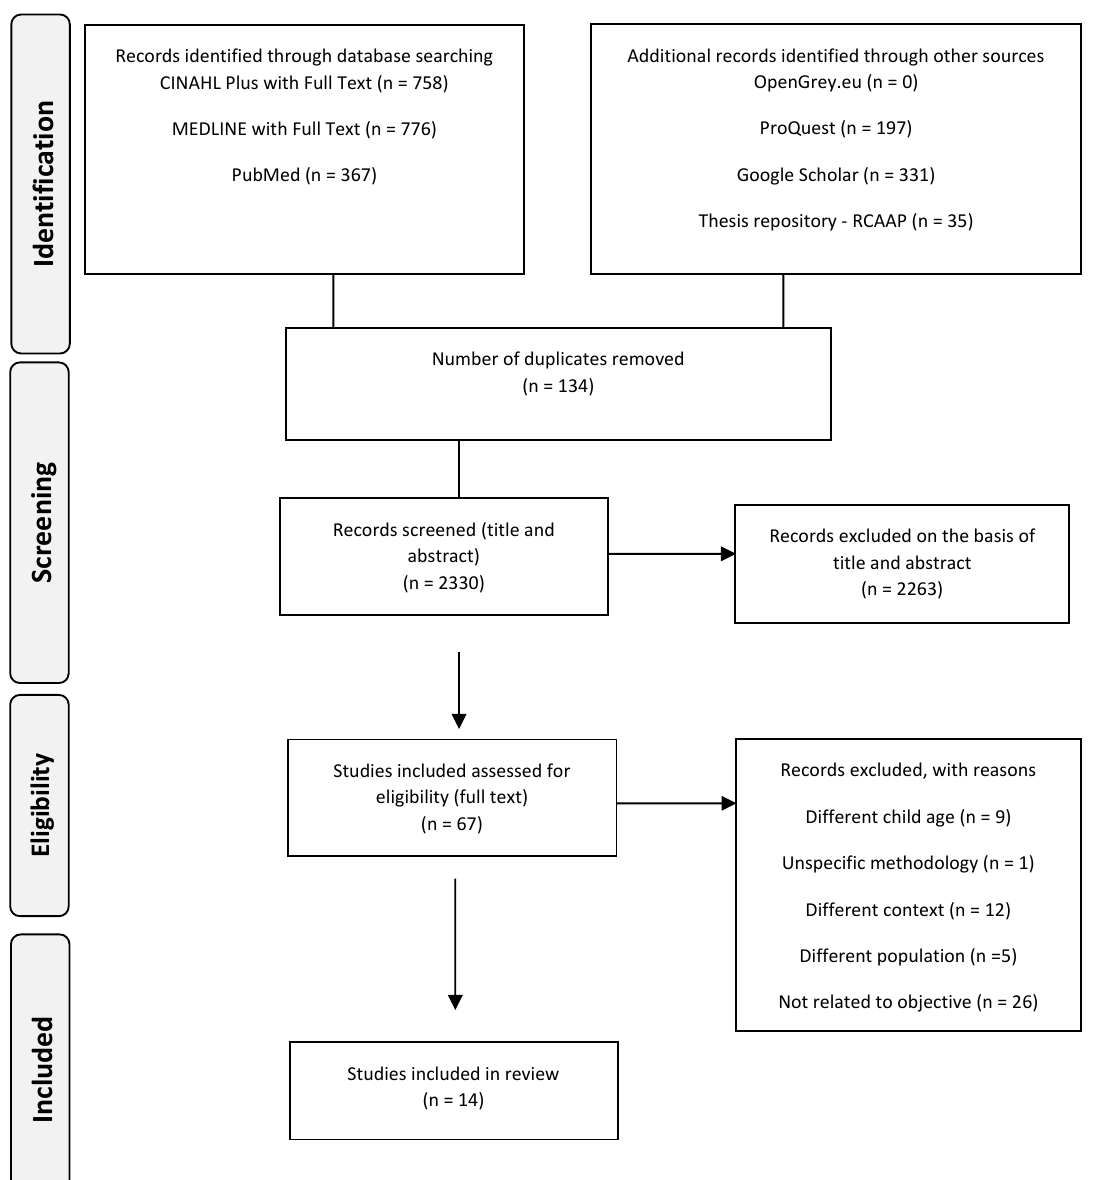
Figure 1. Preferred Reporting Items for Systematic and Meta-Analyses (PRISMA), adapted for scoping review, Flow Diagram